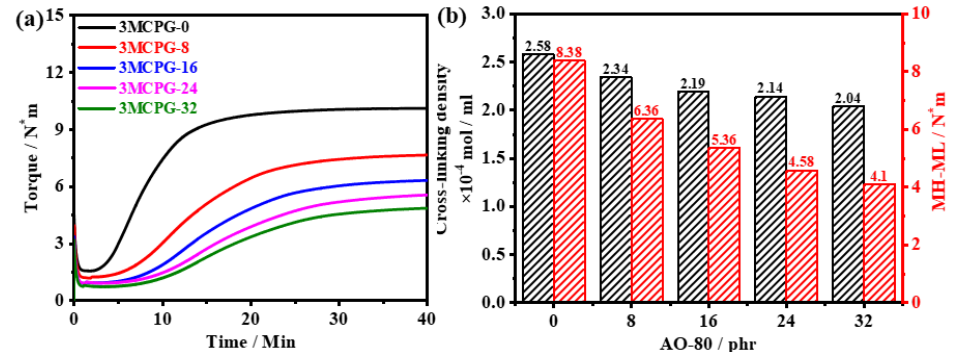
Figure 4. ( a ) Torque vs. melting time of the MPU/AO ‐ 80 composites. ( b ) Crosslinking densities and M H ‐ M L values of the MPU/AO ‐ 80 composites. M H -M L values of the MPU/AO-80